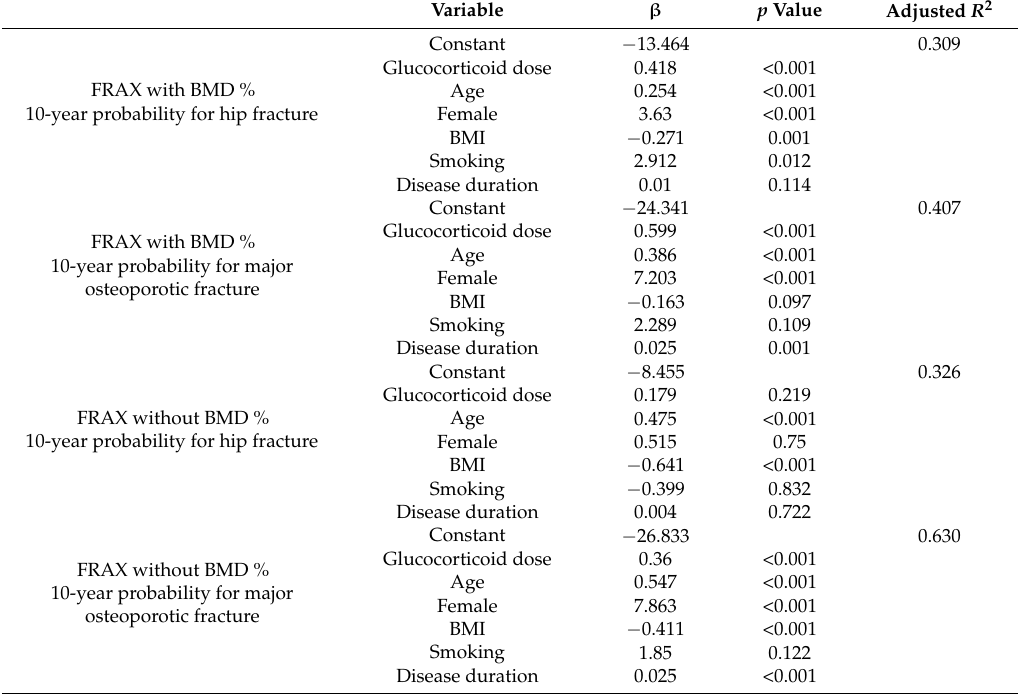
Table 5. Multiple linear risk analyses using the FRAX criteria and the WHO osteoporosis criteria.